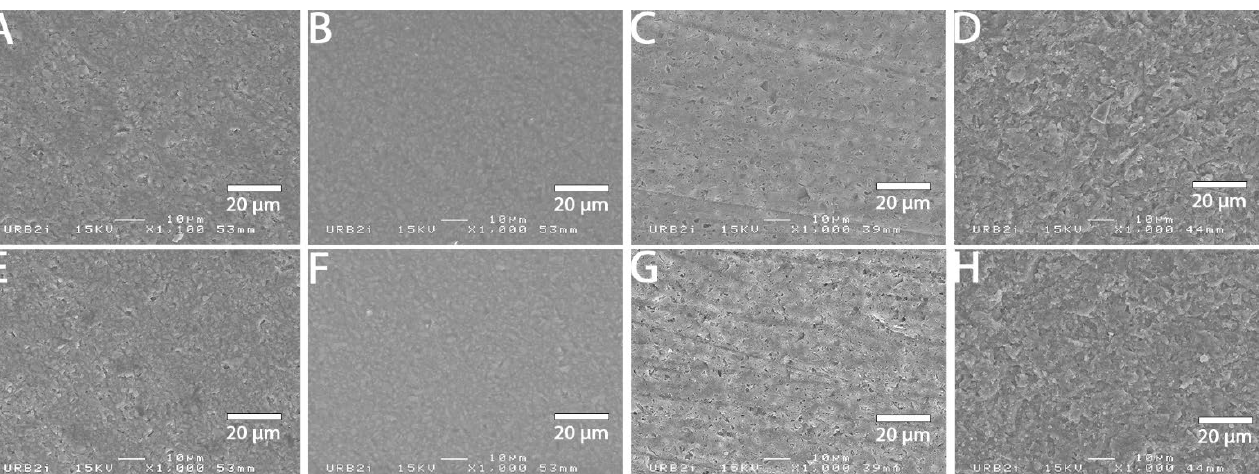
Figure 4. SEM micrograph for Katana Avencia surface (×1000 magnification) with the different sur- face treatments: ( A ) control; ( B ) polyacrylic acid; ( C ) hydrofluoric acid; ( D ) sandblasting; ( E ) 800 grit polishing + universal primer; ( F ) polyacrylic acid + universal primer; ( G ) hydrofluoric acid + uni- versal primer; ( H ) sandblasting + universal primer. Sandblasting surface treatment ( D , H ) shows a more irregular pattern surface than the other ones.